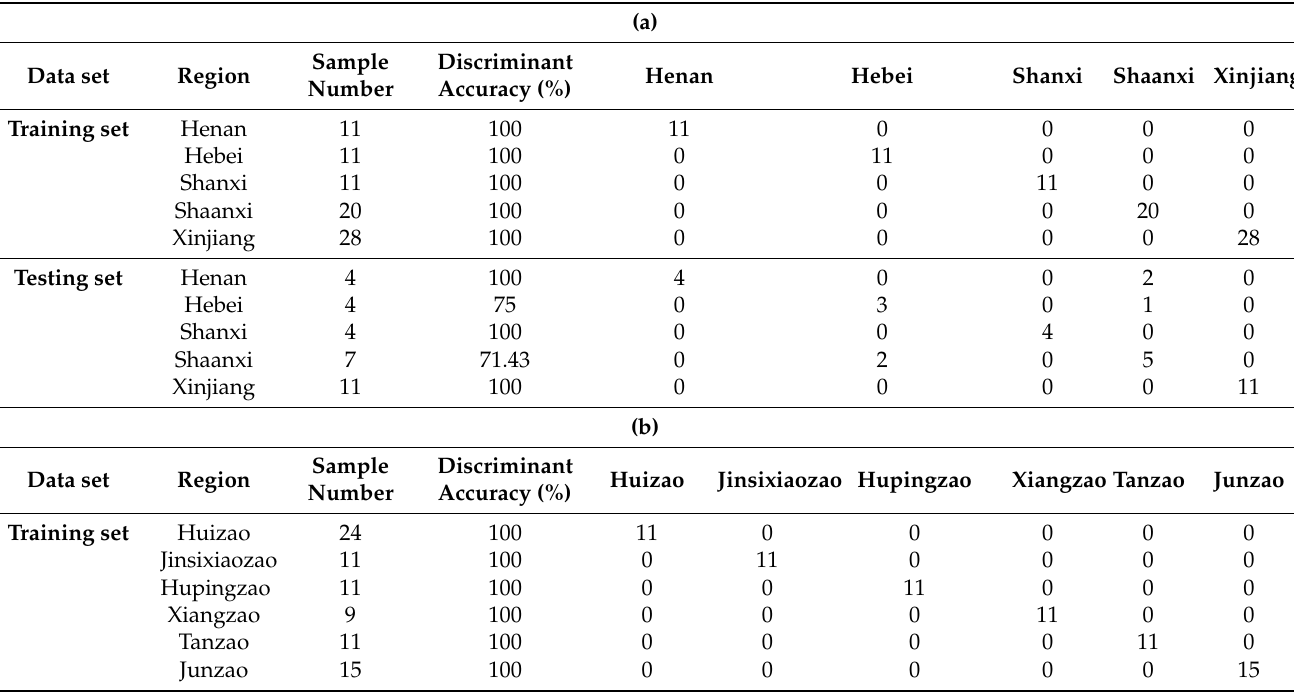
Figure 3. Principal component analysis (PCA), partial least squares-discriminant analysis (PLS-DA), and orthogonal partial least squares-discriminant analysis (OPLS-DA) of Chinese jujube samples in five regions with the eight main quality parameters, and the OPLS-DA model of the five categories of Chinese jujubes samples with the training set and testing set: ( a ) PCA; ( b ) PLS-DA; ( c ) OPLS-DA; ( d ) OPLS-DA model with training set and testing set. Table 4. ( a ) Classification of Chinese jujube samples based on eight main quality parameters by the OPLS-DA model; ( b ) discriminating accuracy of main quality parameters in Chinese jujube samples using the OPLS-DA